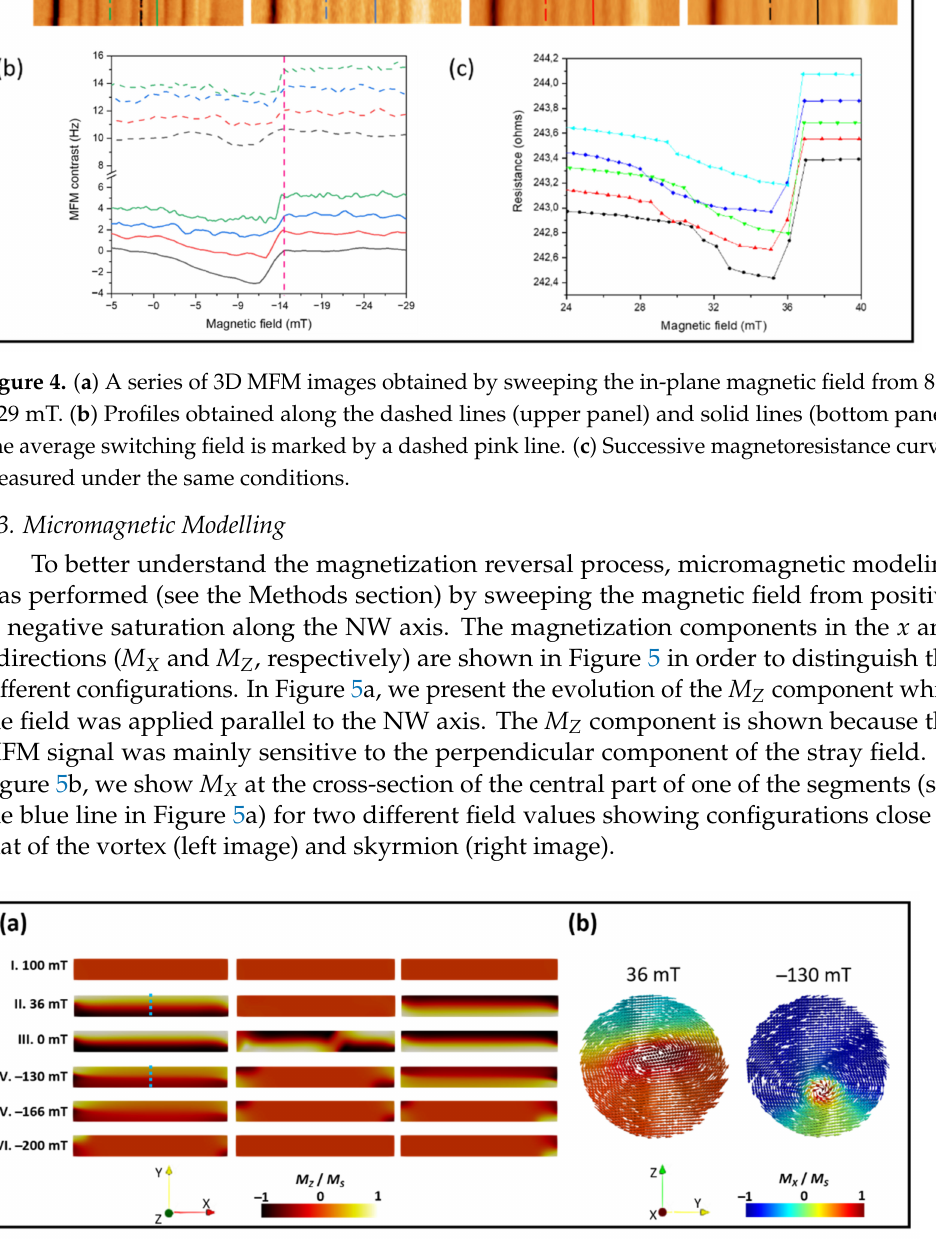
Figure 5. Micromagnetic simulations of a tri-segment nanowire following hysteresis cycle with field applied parallel to NW axis. Nanowire consisted of three CoNi segments spaced between Cu layers ( a ) Magnetization in the z direction of a nanowire at different magnetic field values. ( b ) Cross-sections of the segments are marked in blue in ( a ) for fields of 0 and − 130